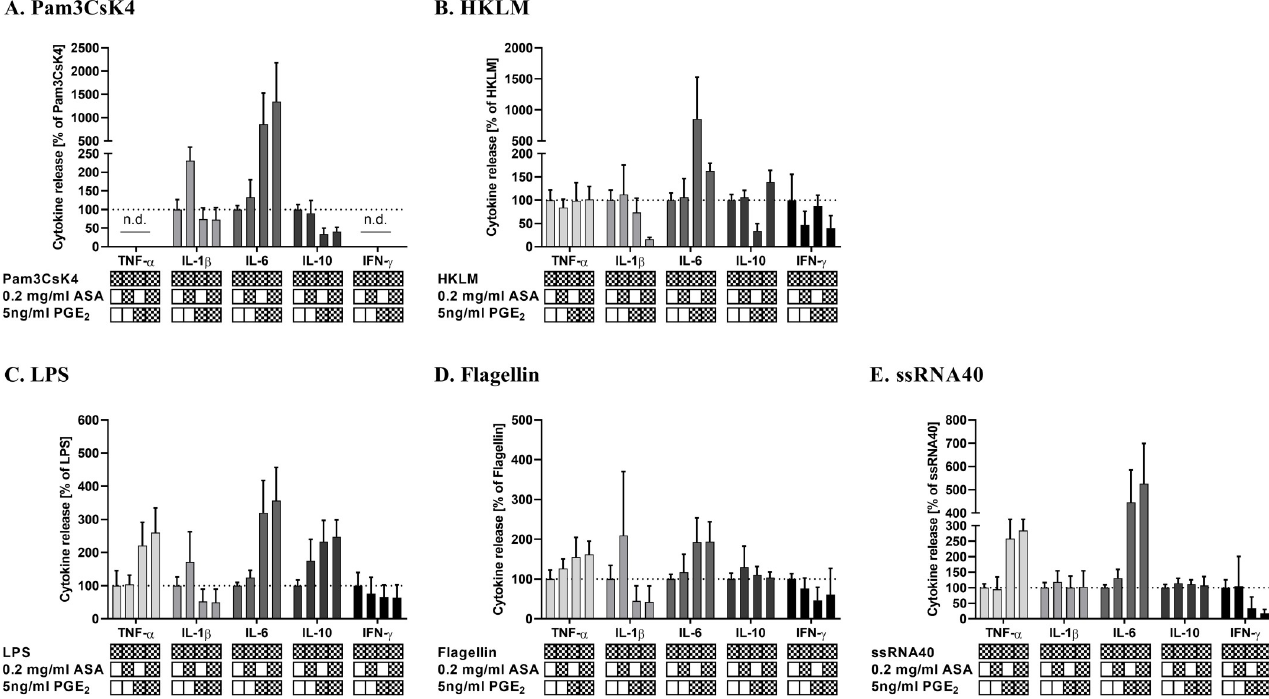
Fig 6. Exogenous addition of PGE 2 antagonizes most of the immunostimulatory effects of ASA. PGE 2 (5 ng/ml) was added to citrate-anticoagulated blood in the presence or absence of 0.2 mg/ml ASA before stimulation with TLR-ligands including (A) Pam3CsK4 (B) HKLM (C) LPS (D) Flagellin and (E) ssRNA40. Stimulated cells incubated without ASA and PGE 2 (vehicle) set as 100%. Data represent mean ± SD of three experiments performed in triplicate.